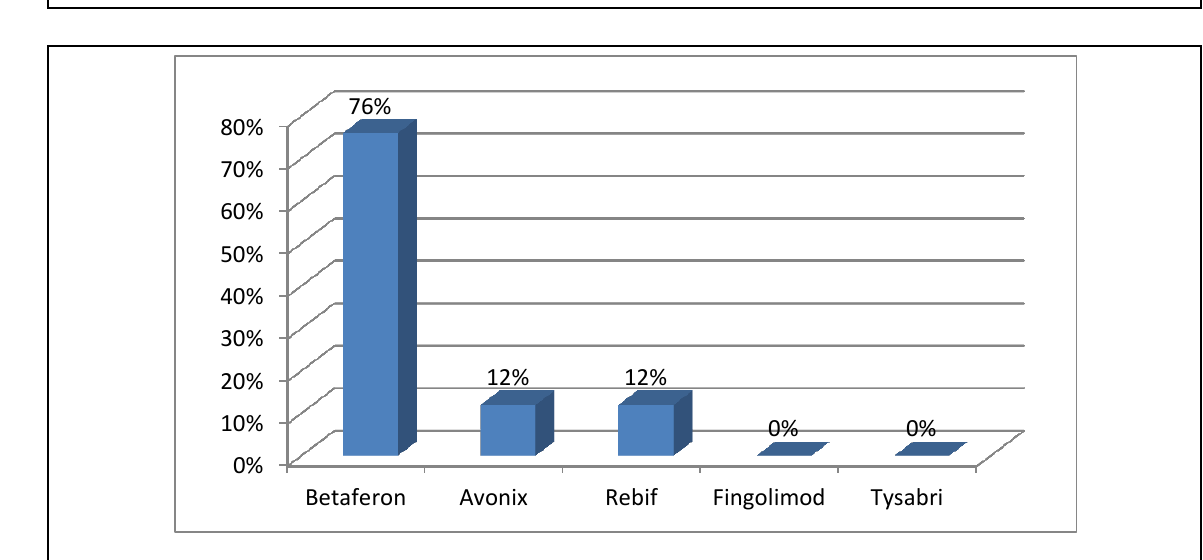
Figure (4) Treatment used in study